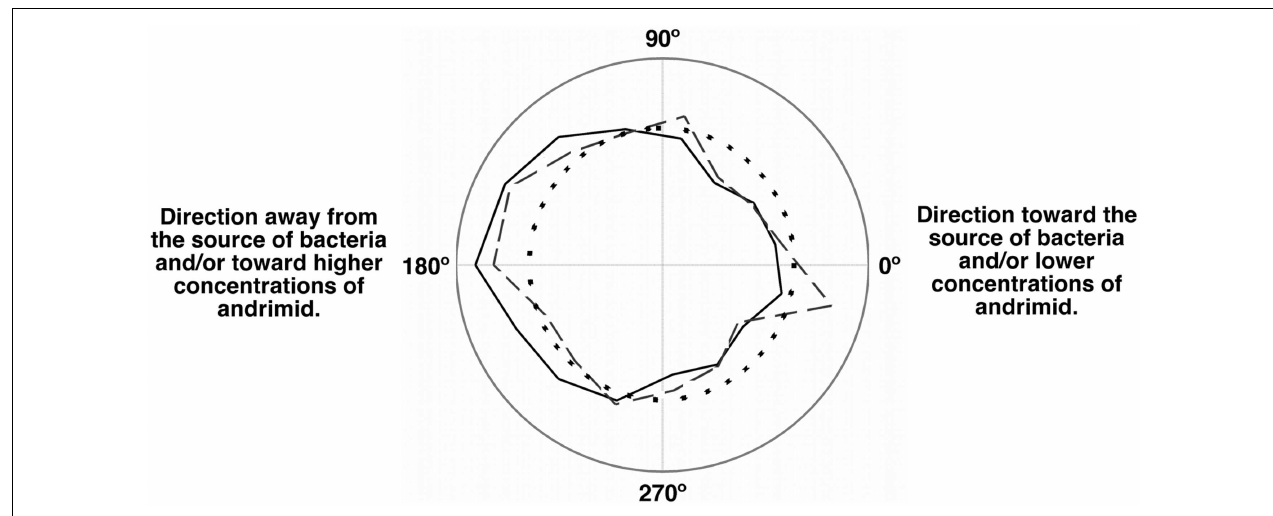
the location of the compound source. In the media control, cells moved preferably down-channel and away from the point of introduction. In the andrimid treatments, a higher proportion of paths were directed toward lower andrimid concentrations and away from the source of the